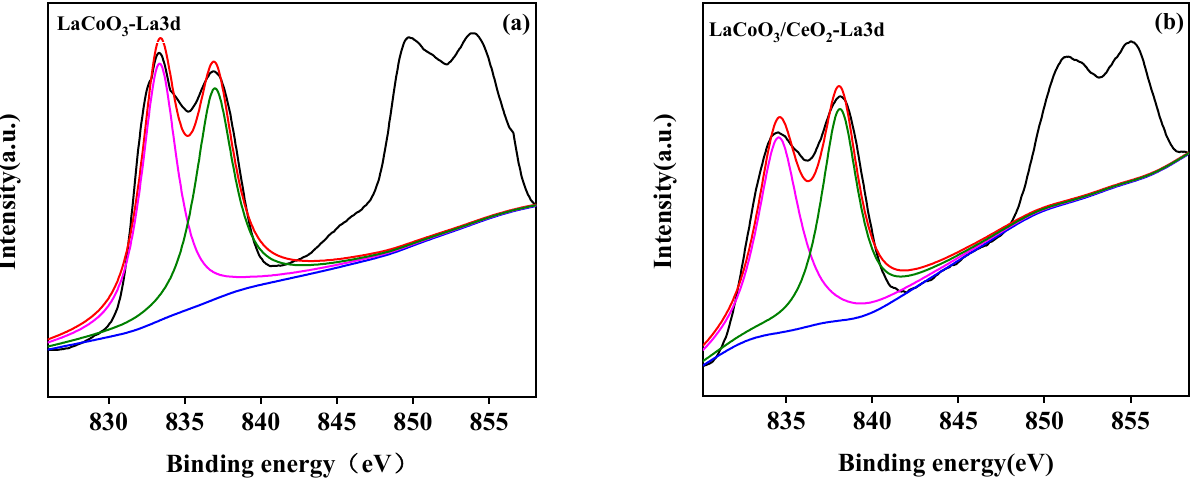
Figure 7. XPS spectra of La3d of LaCoO 3 ( a ) and LaCoO 3 /CeO 2 ( b ).